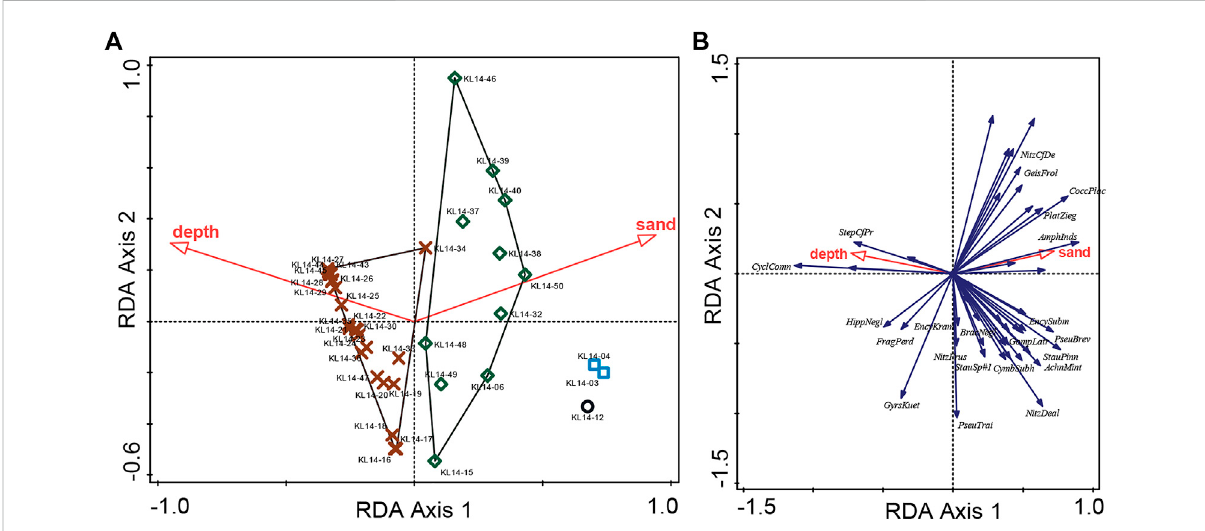
FIGURE 4 Redundancy analysis (RDA) of the surface sediment diatom dataset from Lake Kalakuli with (A) samples coded according to their TWINSPAN groupingsandforwardselectionoftheenvironmentalvariables(ontheleft)and (B) themostabundantspeciesontheright(arrows).Only37samples, with a complete set of associated environmental variables were included in the analysis.